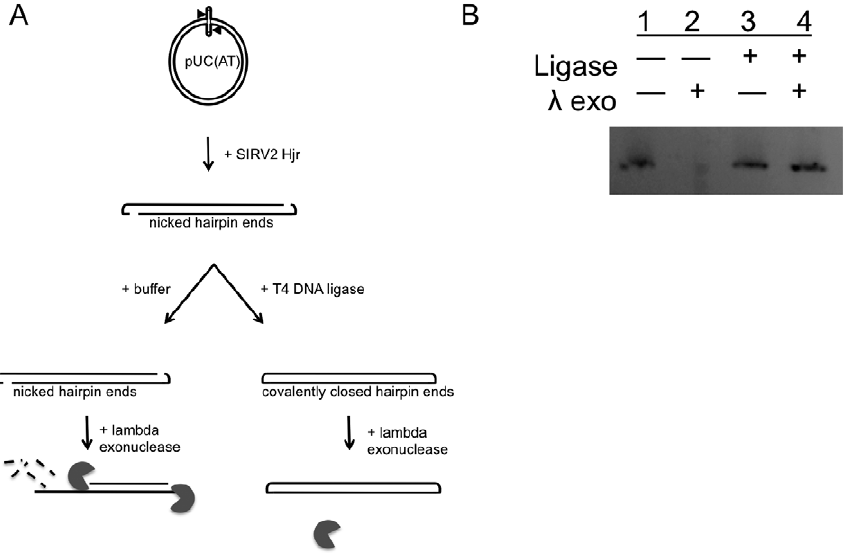
Figure 4. SIRV2 Hjr cleaves hairpin four-way junctions to produce linear fragments with nicked hairpin ends. (A) Hjr was used to cleave the hairpin four-way junction containing plasmid, pUC(AT), to generate linear fragments with nicked hairpin ends. The linear fragments were then incubated with either buffer alone or T4 DNA ligase to seal nicks. Lambda exonuclease (gray shape) was then added to degrade DNA having free 5 9 ends (dotted lines). (B) Hjr cleaved pUC(AT) products were incubated with buffer alone (-) (Lane 1), with lambda exonuclease (Lane 2), with T4 DNA ligase (Lane 3) or with T4 DNA ligase then lambda exonuclease (Lane 4) and separated by agarose gel electrophoresis.